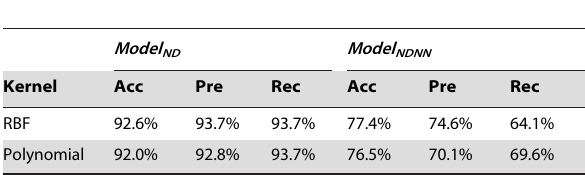
Table 3. Leave-one-out cross validation of two SVM